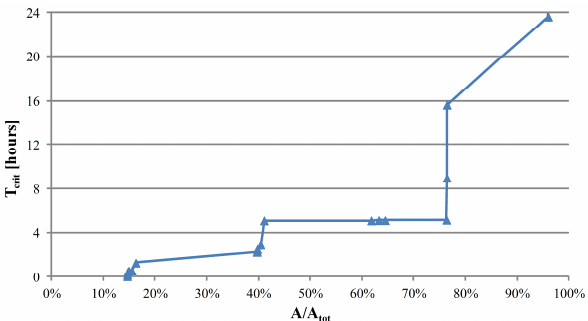
Fig. 7. Threshold values of the rainfall duration for the correct ap- plication of the model. Figure 7. Threshold values of the rainfall duration for the correct application of the model 3